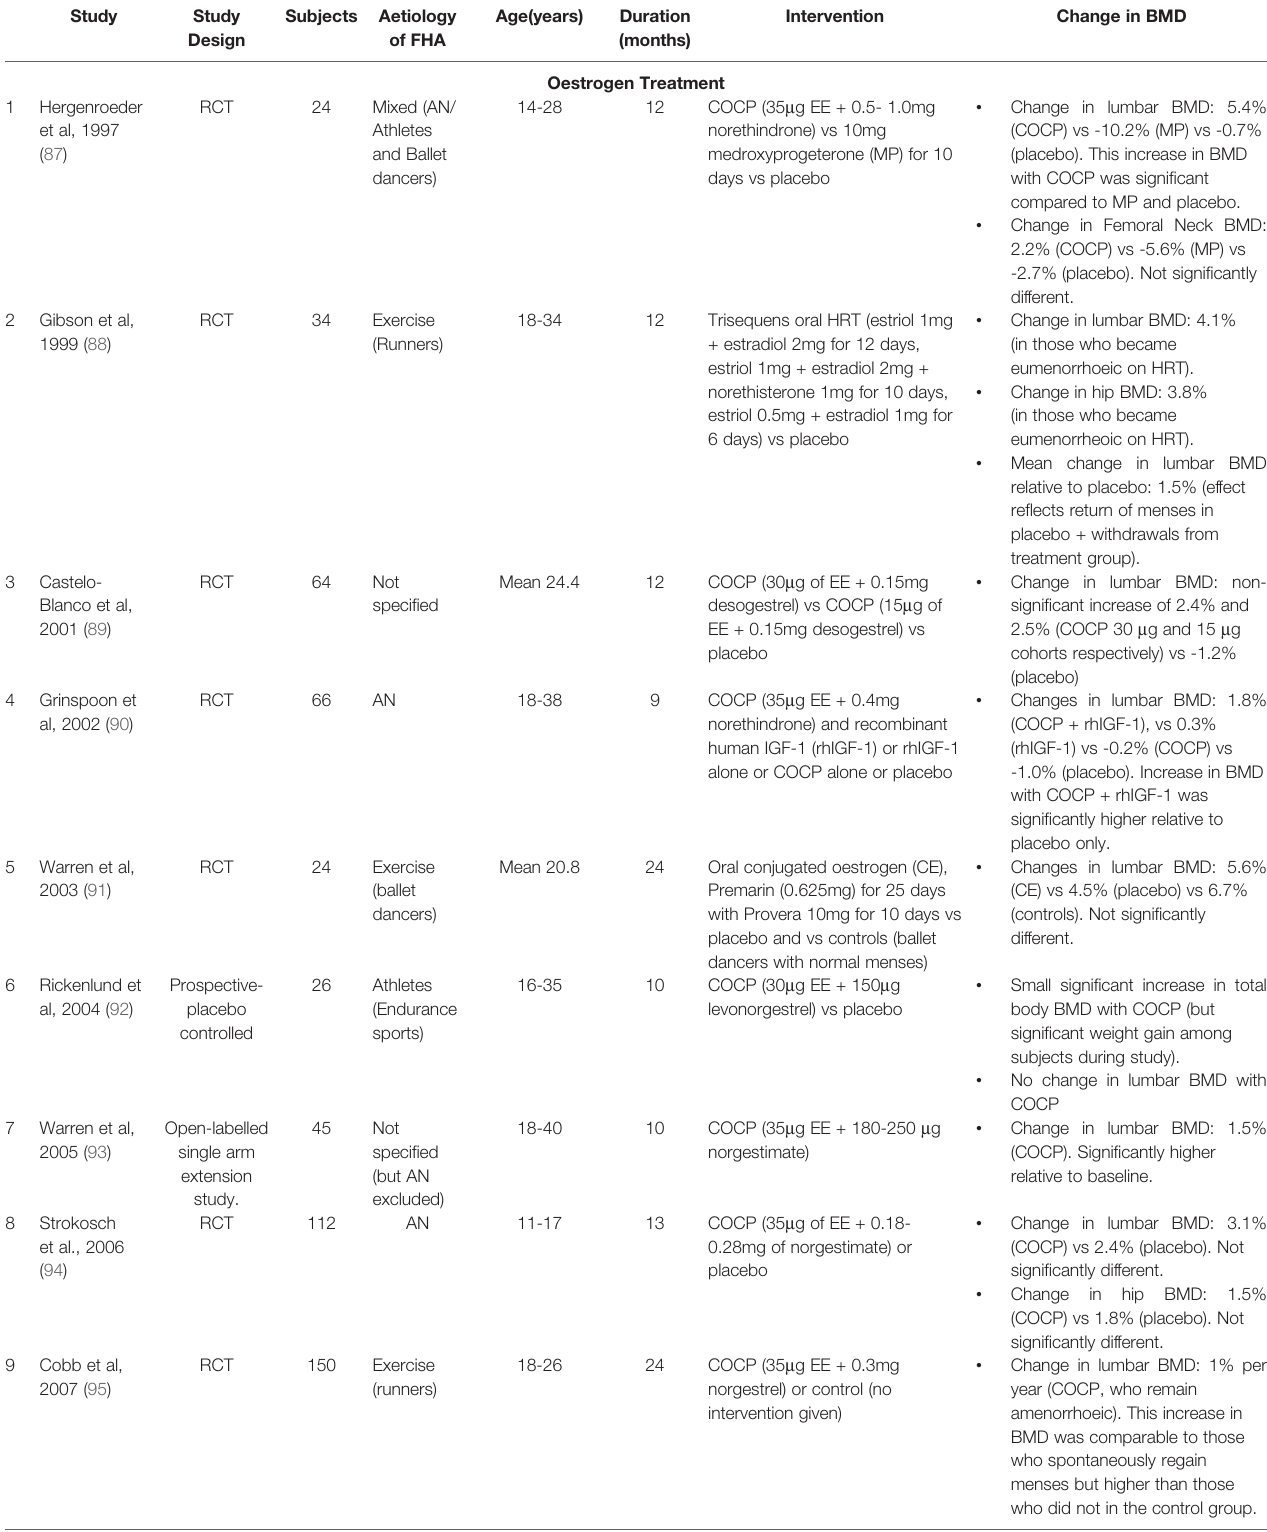
TABLE 1 | Up-to-date summary of oestrogen treatment studies and other hormonal/pharmacological interventional studies in women with FHA.